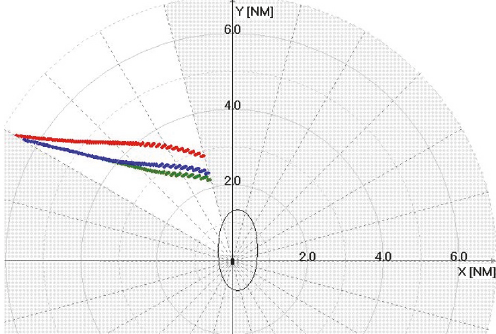
Figure 22: Action lines for stand-on crossing encounter with a target, whose true speed is 23 knots. Assumed are turns to starboard by 30 ∘ (red), 45 ∘ (blue), and 60 ∘ (green). No speed reduction.